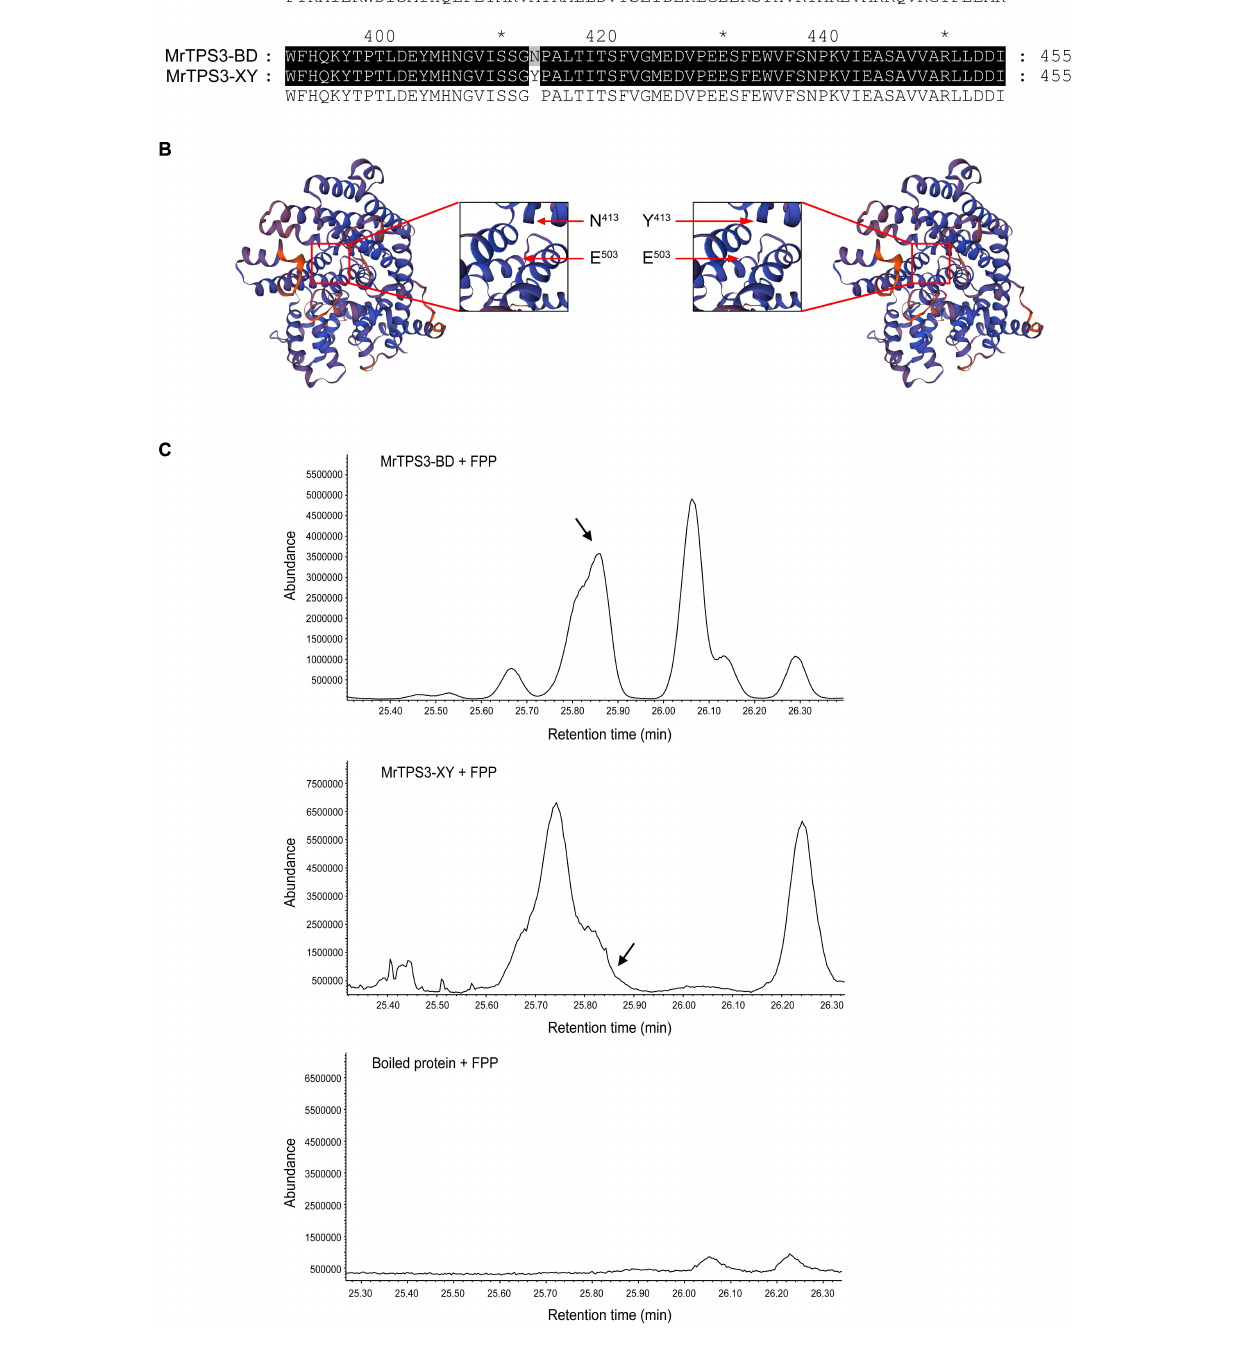
FIGURE 6 | Functional characterization of MrTPS3. (A) Protein sequence alignment of MrTPS3 in ‘Biqi’/‘Dongkui’ (MrTPS3-BD) and in ‘Xiazhihong’/‘Y2012-145’ (MrTPS3-XY). (B) Protein 3D models for MrTPS3-BD and MrTPS3-XY. Pictures in the red box showed the zoom in of the picture. Arrows indicate the amino acid substitution and the structure change. (C) Enzyme activity assays of MrTPS3 using prokaryotic-expressed protein. GPP and FPP served as substrates and β -caryophyllene was the product. GC-MS was used to detect the reaction. Boiled MrTPS3 protein served as a negative control. The arrows show the peak of β -caryophyllene. The stars show the locations of amino acid sequence and the interval is 20 aa.